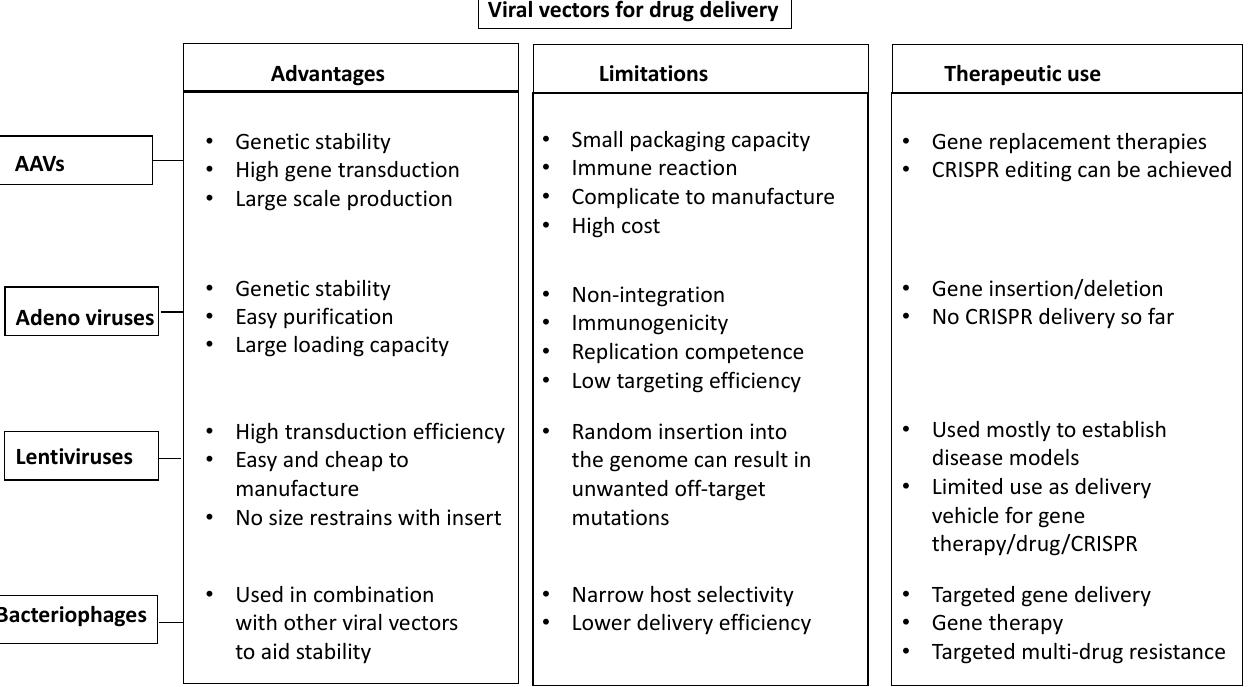
Figure 3. Viral-based delivery vectors. Schematic diagram showing the advantages, limitations, and therapeutic uses of the four main viral-based vehicles for CRISPR-reagents delivery: AAVs, Adenoviruses, Lentiviruses, and Bacteriophages.